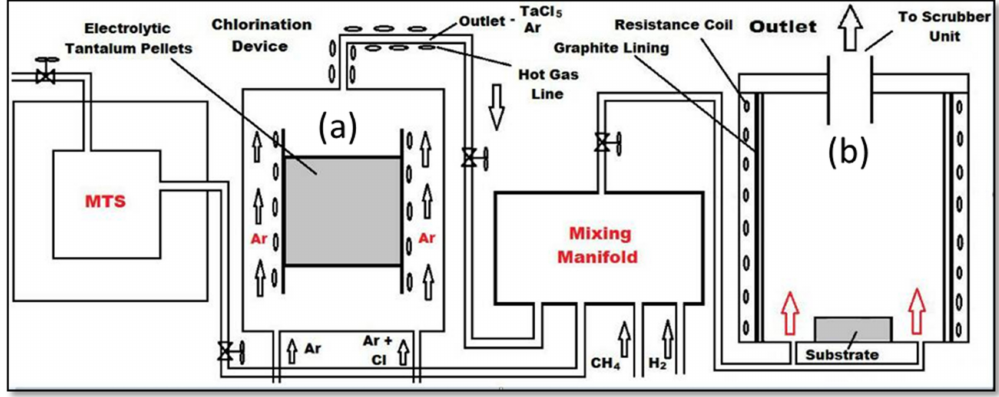
Figure 1. Typical scheme of the TaC deposition unit: ( a ) in situ chlorination device; ( b ) CVD